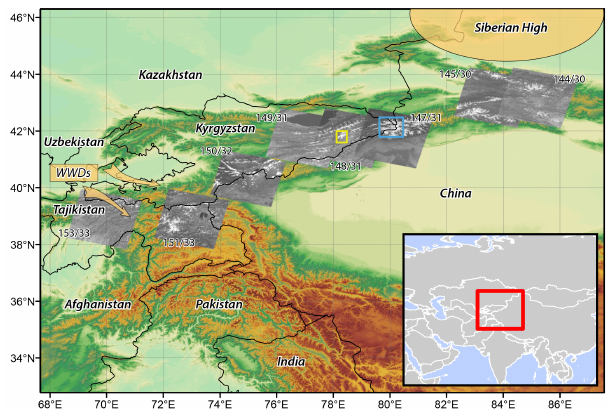
Figure 1. Greater study area of the Tien Shan, showing SRTM v4.1 topography (Jarvis et al., 2008) and location of eight Landsat image footprints (grayscale) used in the study, along with their Path/Row combinations. Blue box delineates Figs. 2, 3 and 7, yellow box delineates Fig. 8. Winter westerly disturbances and Siberian High highlighted in